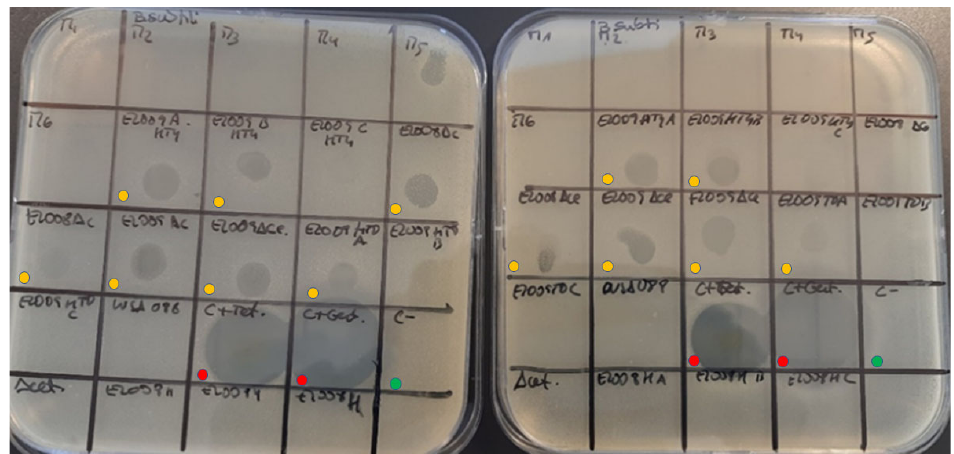
Figure 5. Inhibition halos (positive results) against Bacillus subtilis . Positive controls (Gentamicin 2 mg mL − 1 ) are marked with a red circle, blanks (sodium phosphate bu ff er, 0.01 M, pH 7.5) with green circles and positive inhibition samples with yellow circles.